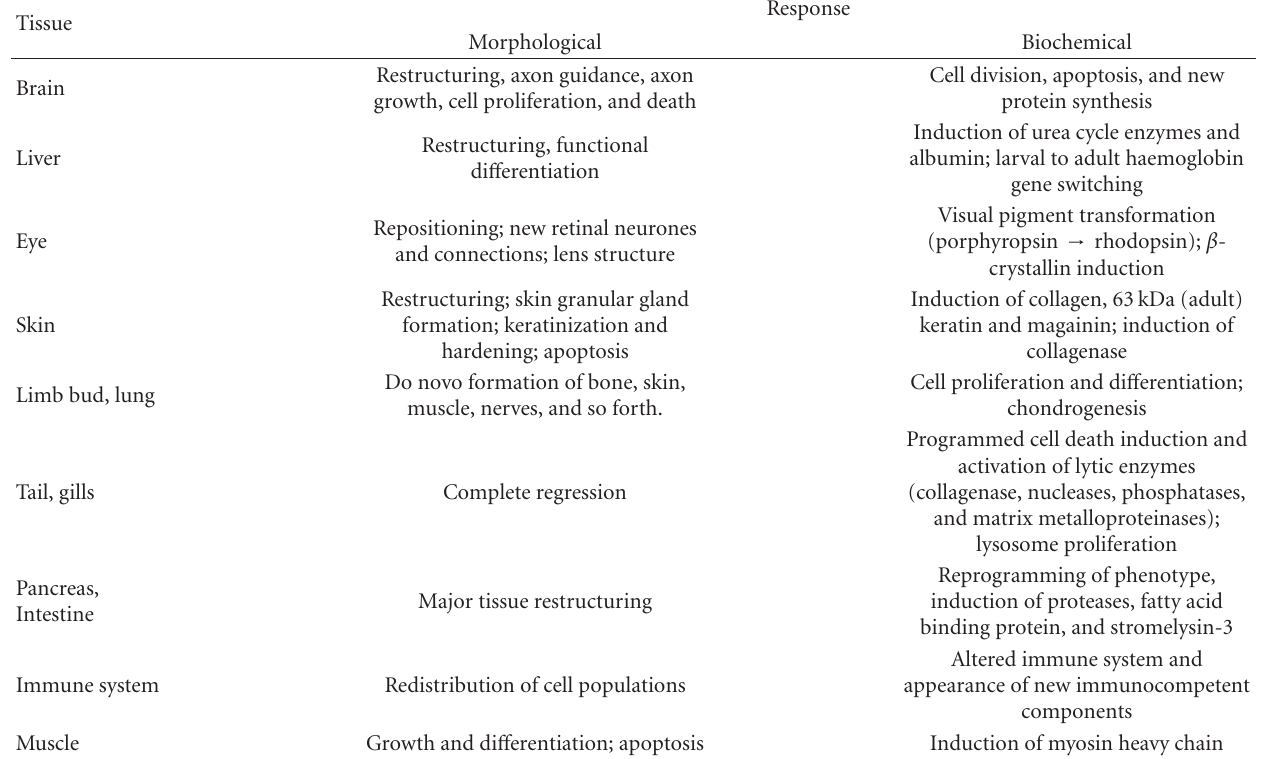
Table 2: Morphological and biochemical responses to thyroid hormone during amphibian